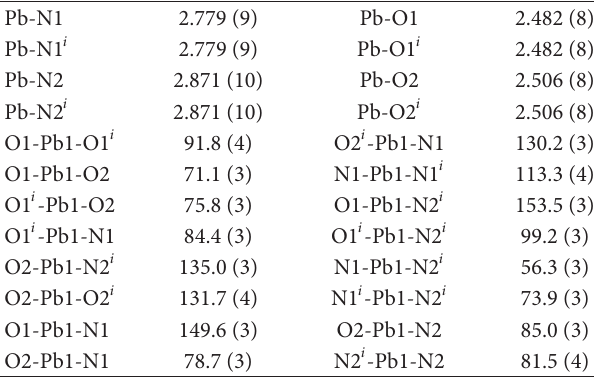
T 2: Selected bond lengths (Å) and angles